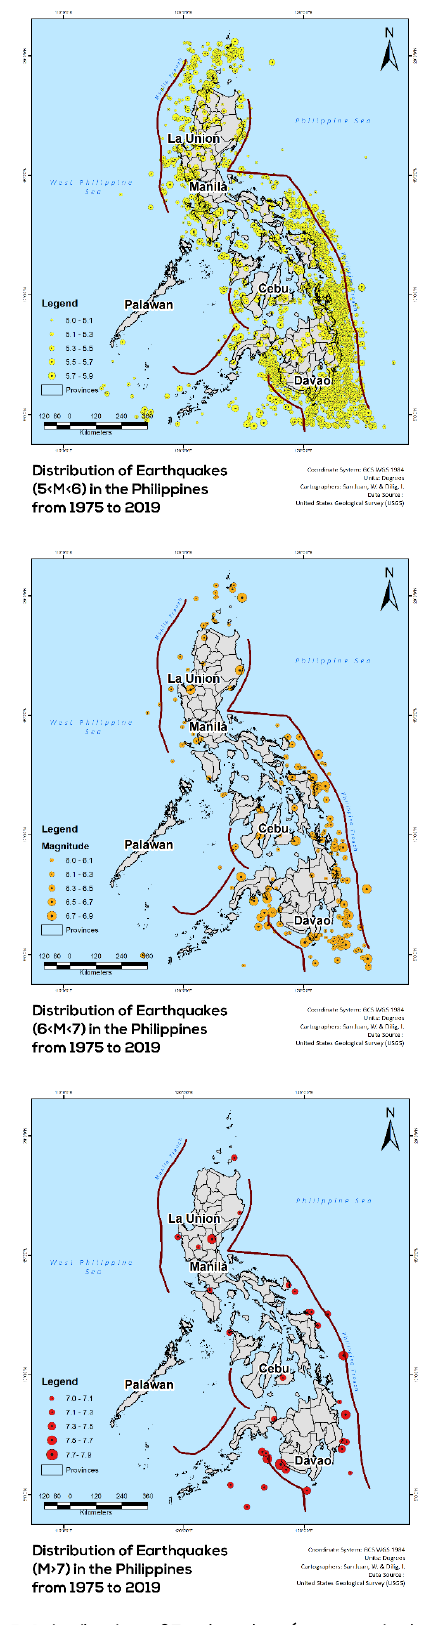
Figure 5. Distribution of Earthquakes (per magnitude) in the Philippines from 1975 to